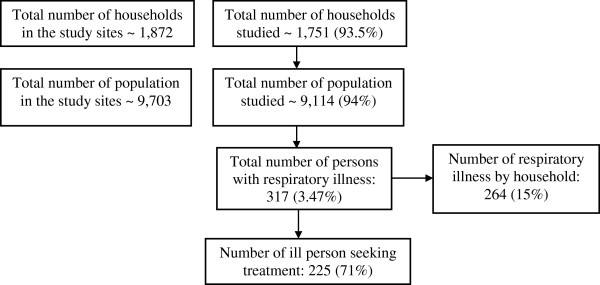
Flow chart of study population.